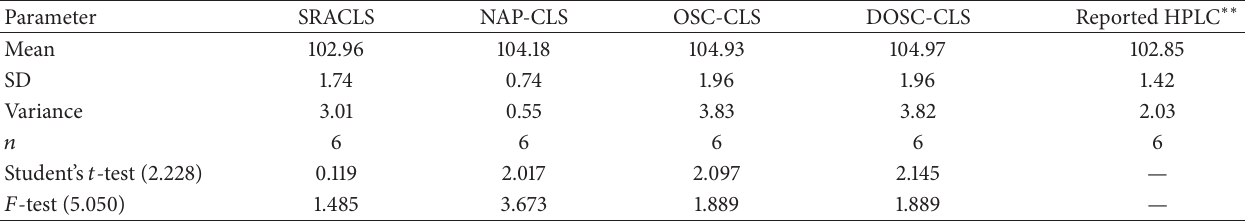
Table 4: Statistical comparison of the results obtained by the proposed methods and the reported HPLC method for determination of CEF in pharmaceutical formulation (Cefobid (cid:2) Vial).